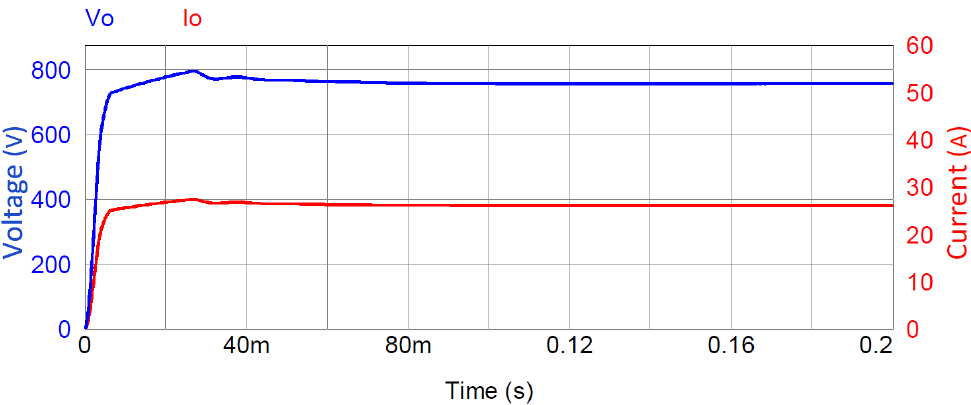
Figure 18. Voltage and current at the rectifier output.